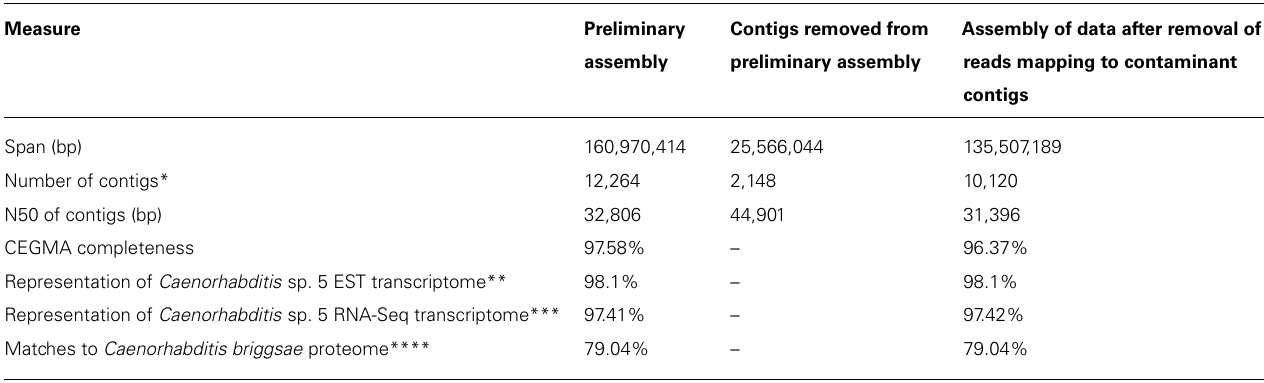
Table 3 |Assembly statistics for Caenorhabditis sp.